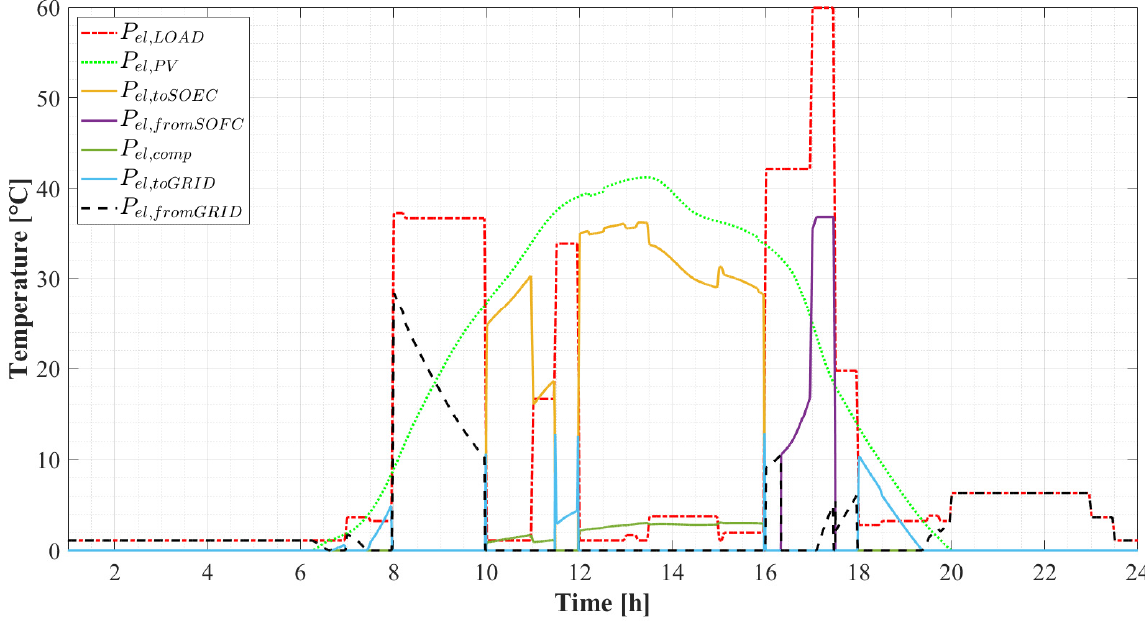
Figure 7. Dynamic results for the electricity transient analysis.